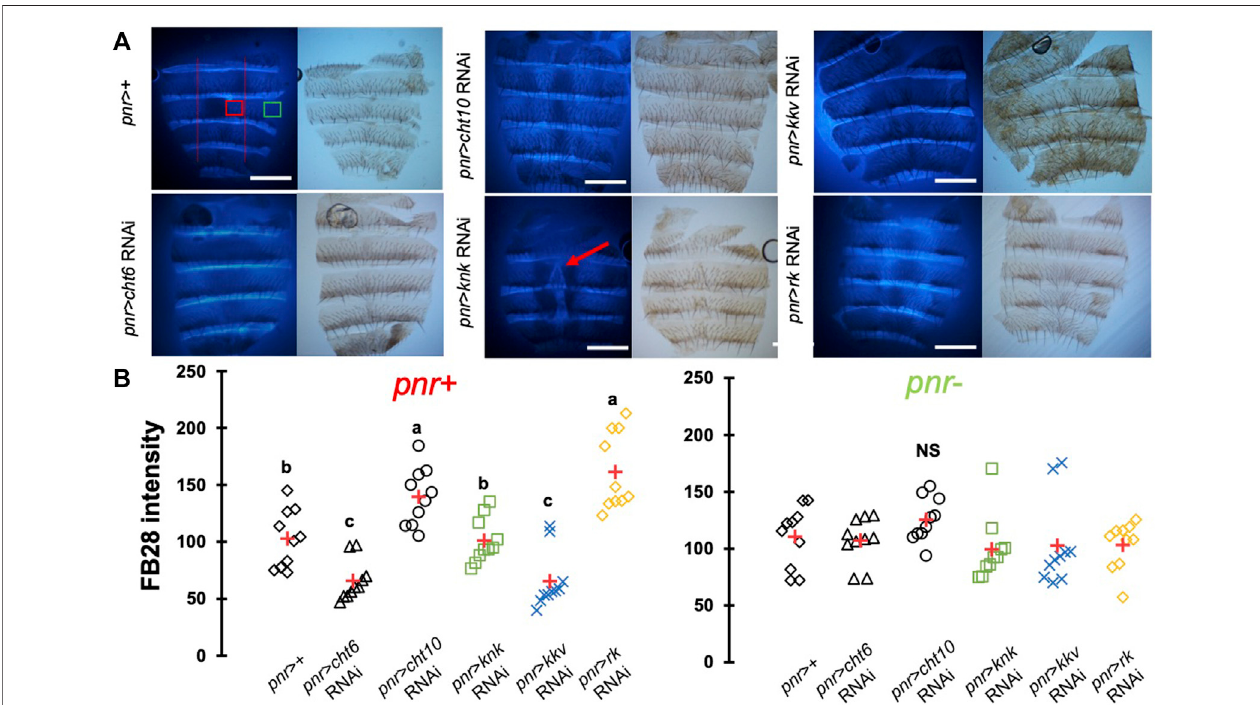
FIGURE 3 | FB28 hot staining combined with transgene differentially expressed in the abdominal epidermis reveal how speci fi c genes affect chitinous content. (A) 3 h-old female dorsal abdomens stained with FB28 (65 ° C during 60 min). pannier -GAL4 was used to speci fi cally drive RNAi expression in the central part of the abdomen. Four chitin-related genes, chitinase 6 ( cht6 ), chitinase 10 ( cht10 ), knickkopf ( knk ) and chitin synthase 1 ( kkv ) were down-regulated. Additionally, the gene coding for the “ tanning-hormone ” receptor DLGR2 ( rk ) was down-regulated. Red line indicates the zone used for quanti fi cation of pannier expressing zone ( pnr+ ). Greenlineindicatesthezoneusedforquanti fi cationof pnr non-expressingzone( pnr- ).Scalebar=0.3 mm. (B) FB28intensityquanti fi cation.FB28intensityin pnr+ zone (right)and pnr- zone(left)areshown.Dataarerepresentedasscattergramsshowingalldatapointswiththemean(redcrosses).Differentmarkershapes/colorsrepresent thedifferentgenotypes.Differentlettersindicatestatisticallysigni fi cantdifferences(onewayANOVAtestfollowedbyaTukeyHSDprocedure, p -value < 0,0001). n =10in each group.